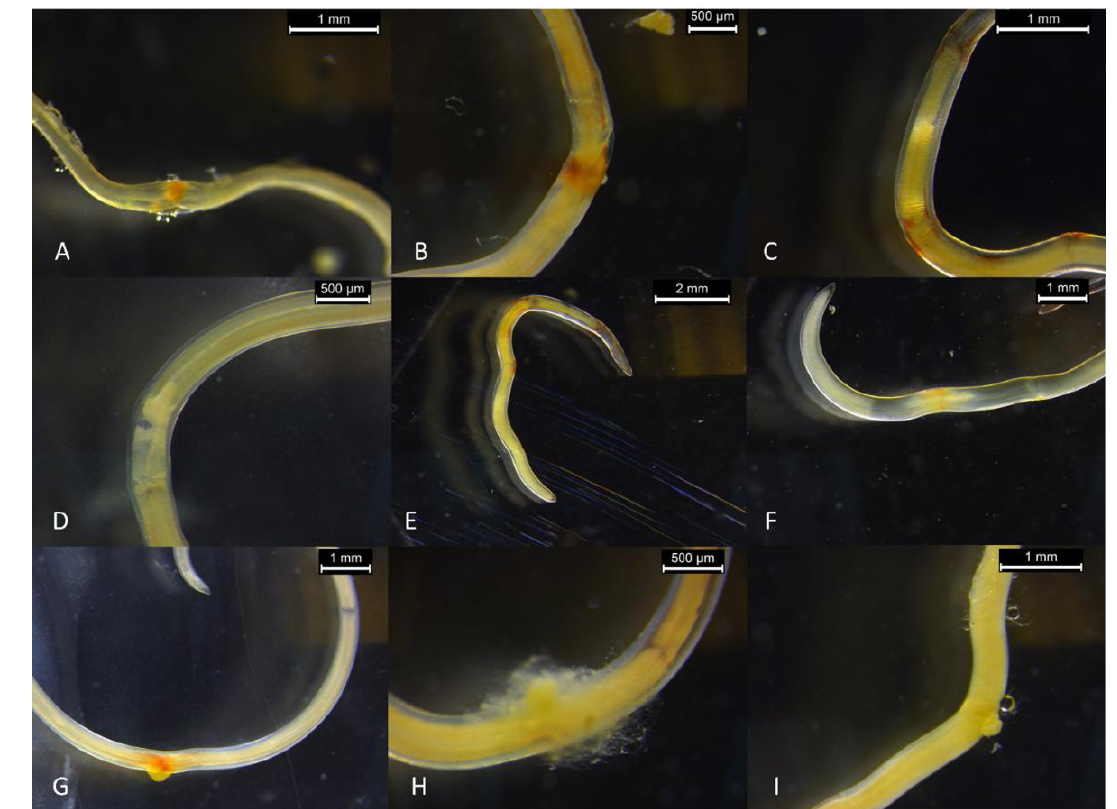
Figure 4. Examples of damages and lesions observed under a stereomicroscope in Anisakis larvae experimentally parasitized in anchovy fillets treated with different concentrations of limonene during the traditional industrial marinating process: ( A ) continuous lesions of the cuticle; ( B ) continuous lesions of the cuticle; ( C ) slight damages of the cuticle; ( D ) interruptions of the digestive tract; ( E ) slight damages of the cuticle and interruptions of the digestive tract; ( F ) interruptions of the digestive tract; ( G ) continuous lesions of the cuticle associated with leak of the digestive tract; ( H ) continuous lesions of the cuticle associated with leak of the digestive tract. In picture ( I ), the absence of lesions in Anisakis larvae in a control sample.